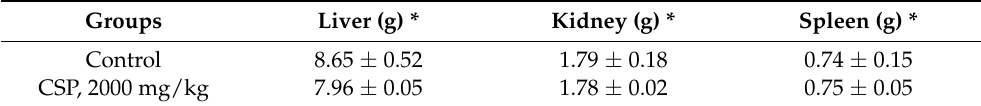
Table 2. Assessment of a relative weight of organs in the acute toxicity study. Table 3. Biochemical parameters of mice.